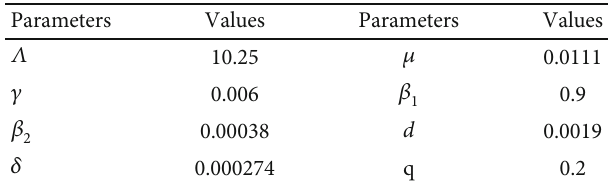
Table 5: Parameter values are used for showing the e ff ectiveness of the control program.